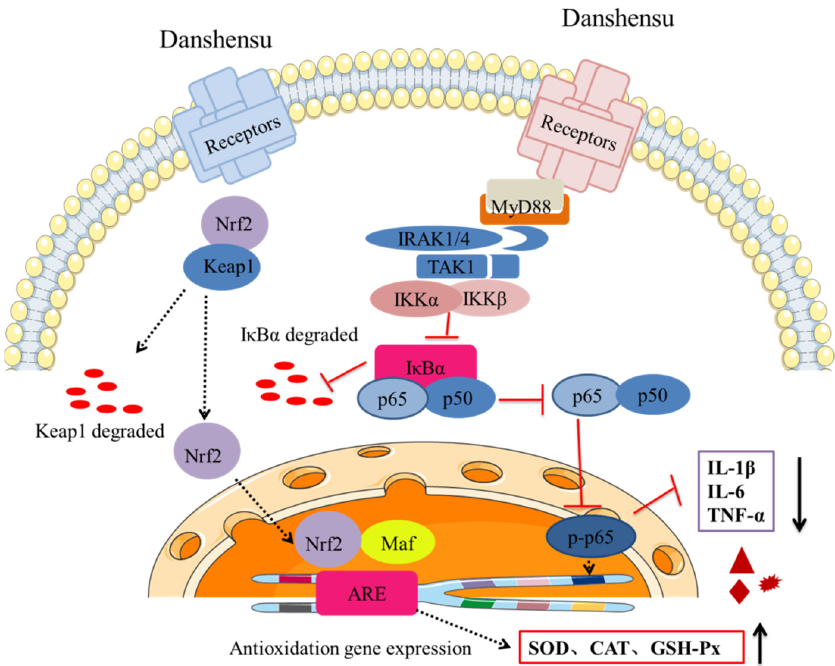
Figure 8. SDSS cream repaired PU in mice, possibly by activating Nrf2/HO-1 pathway and inhibiting the NF- κ B pathway.